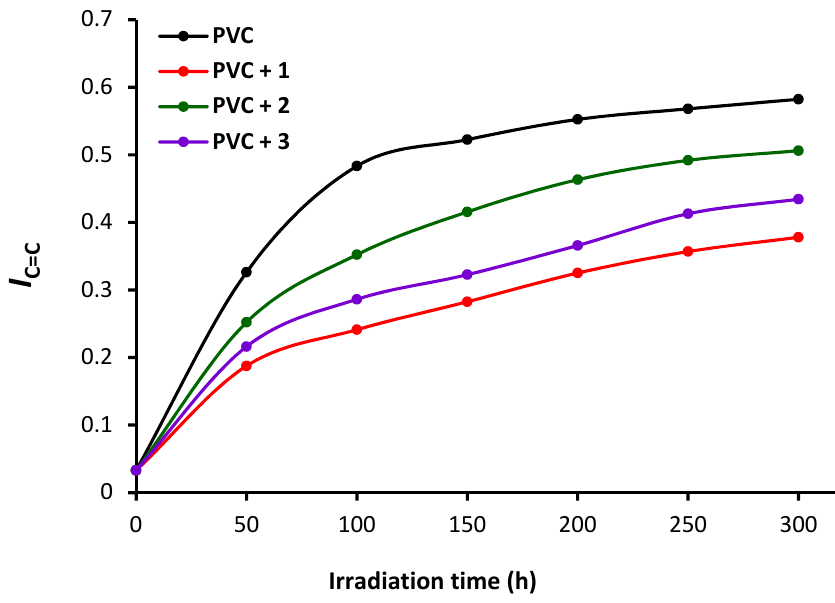
Figure 6. Changes in the I C = C upon irradiation.